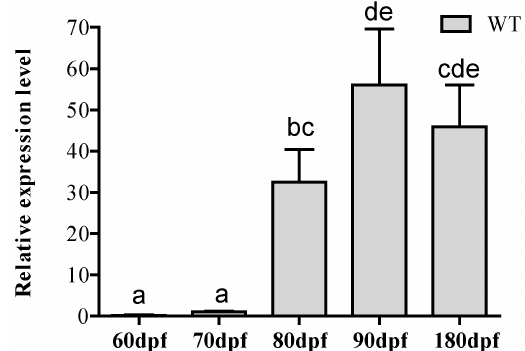
Figure 1. Relative expression levels of miR-34a in the testis of wild-type (WT) zebrafish at different developmental stages.